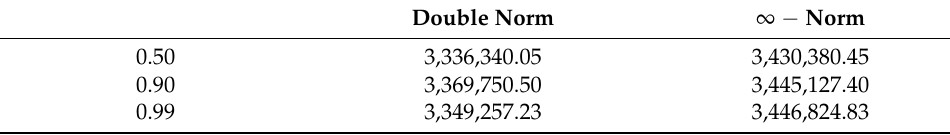
Table 20. Comparison of the results of Cases 1 and